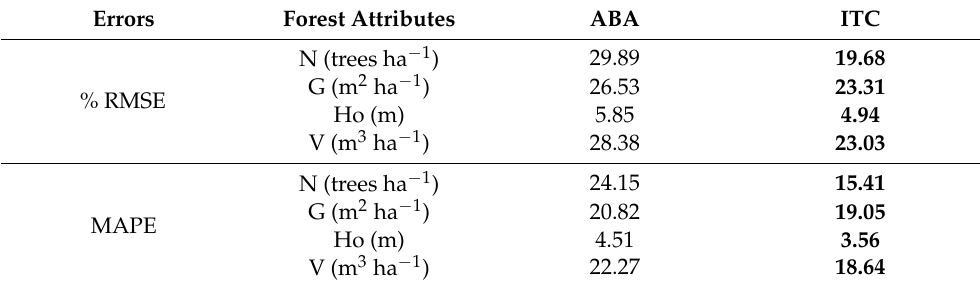
Table 3. Errors (%RMSE and MAPE) obtained for the forest inventory attributes of Pinus radiata stands in Ñuble Region (South, Chile) using the Area-Based Approach (ABA) and Individual Tree Crown (ITC) models (see Table 2, n = 48 plots). The lowest error for each variable is highlighted in bold. Density (N, trees ha − 1 ), Assman ´ s dominant height (Ho, m), Basal area (G, m 2 ha − 1 ), Volume (V, m 3 ha − 1